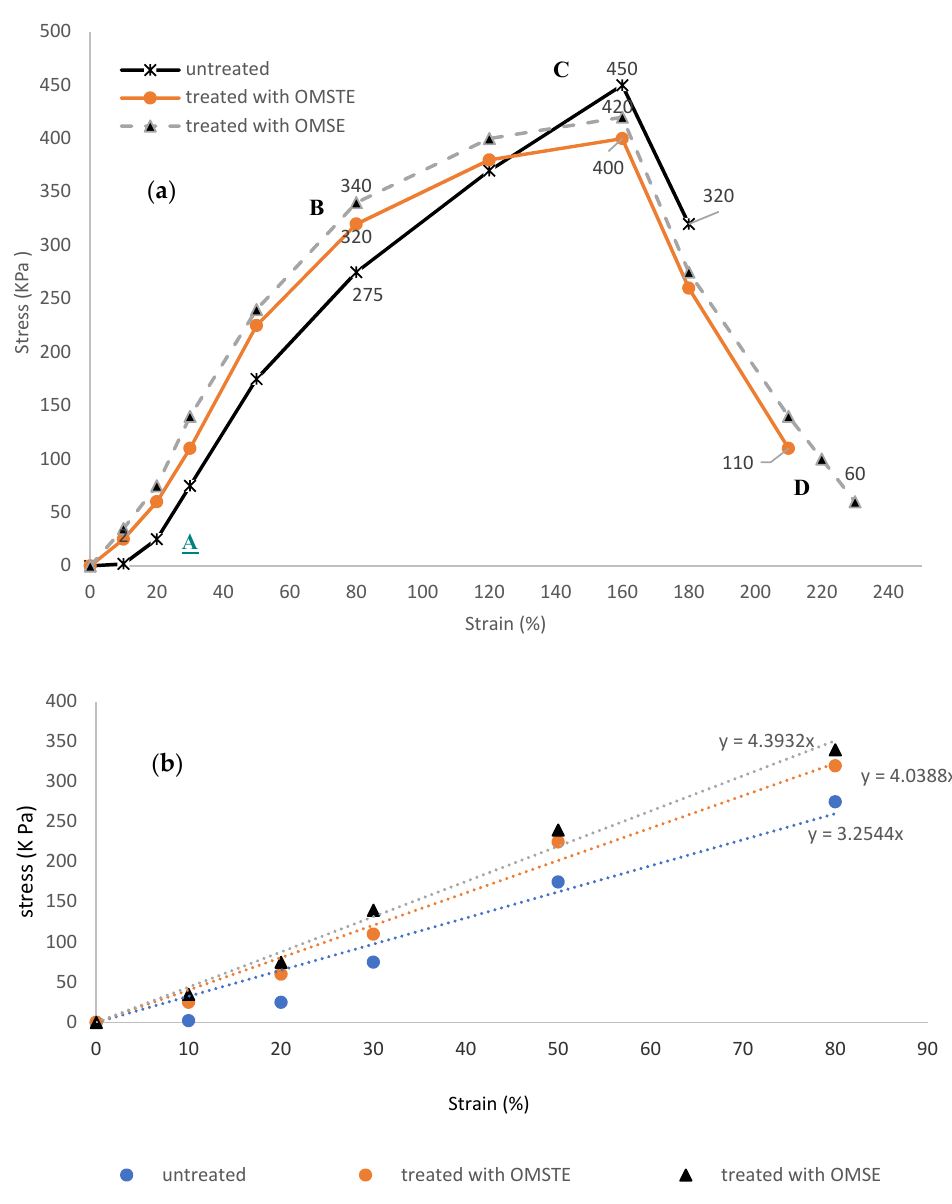
Figure 12. ( a ) The relation between stress σ (KPa) as a function of the strain ε (%) for untreated and treated samples with DC plasma reactors OMTSE and OMSE. ( b ) The elastic region AB, exhibiting straight lines, with the slope represents Young’s modulus (stiffness).